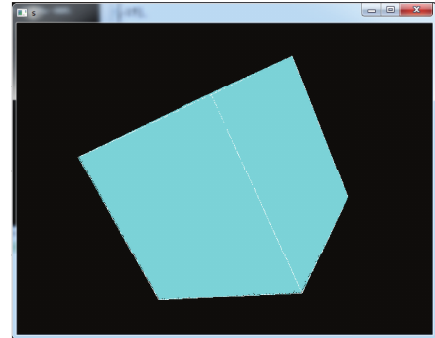
Figure 3: 3D pore network model.